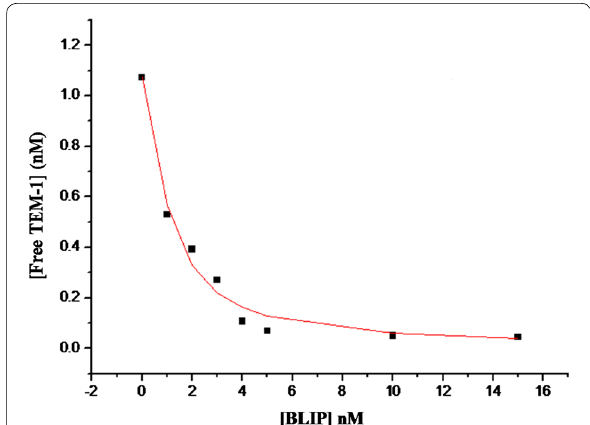
Fig. 4 Determination of the K i value of the P. pastoris ‑expressed BLIP against the TEM‑1 β‑lactamase. 1.5 nM TEM1 β‑lactamase was pre‑incubated with varying concentrations of BLIP (0–15 nM) in 50 mM sodium phosphate buffer containing 1 mg/mL bovine serum albumin for 2 h at 25 °C. Remaining concentration of free β‑lactamase at varying concentrations of BLIP was then estimated by the spec‑ trometric β‑lactamase assay using nitrocefin as a substrate. The plot of concentrations of free β‑lactamase versus varying amount of BLIP represents the nonlinear regression fit of the data to Eq. (1) for the K i calculation using the program OriginPro 6.0. Each point represents a single measurement. The experiment was repeated in duplicate. The determined K i was 0.55 0.07 nM ±